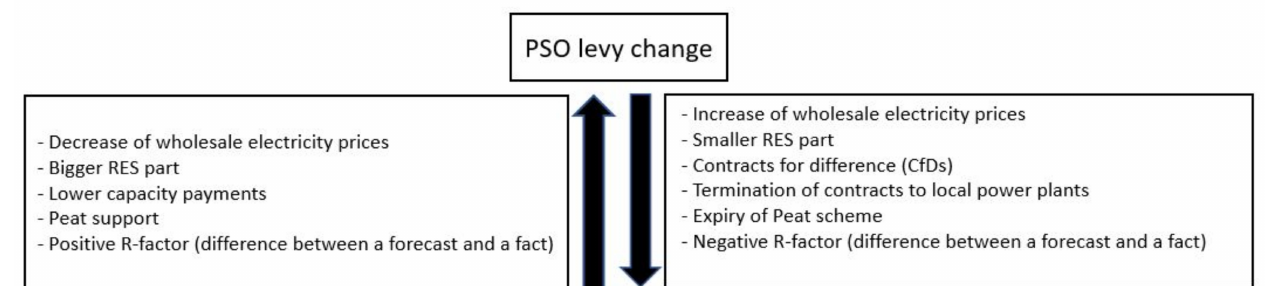
Figure 9. Factors of Irish PSO levy changes (designed by the authors based on [101,106–115]. The distribution of the 2020/21 PSO levy applied in Ireland is shown in Appendix D.